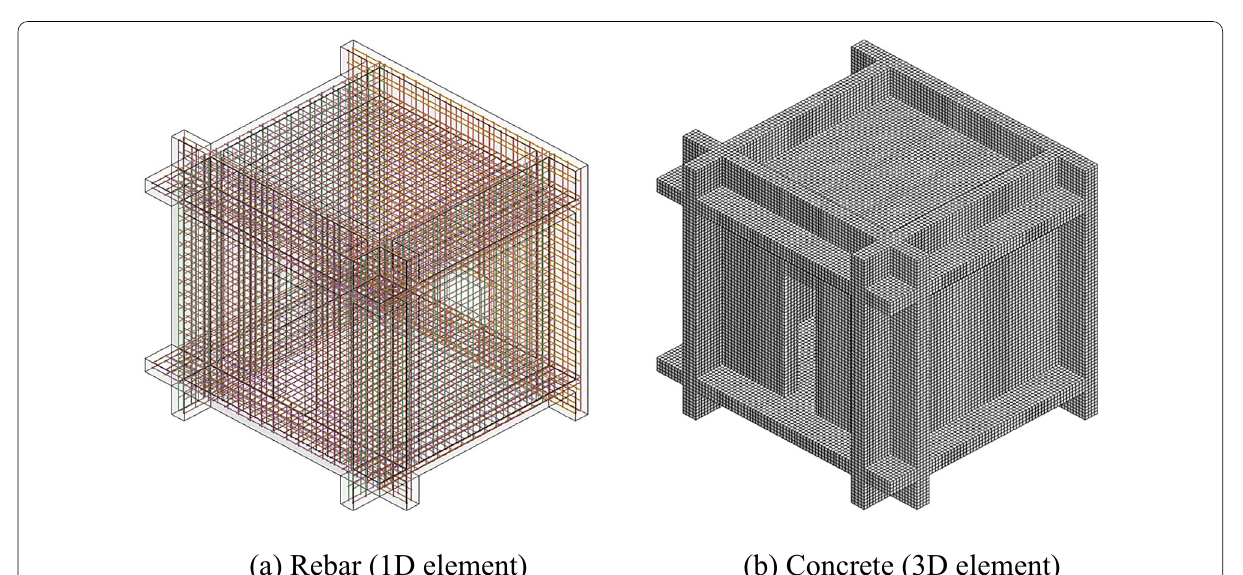
Fig. 16 Rebar shape.